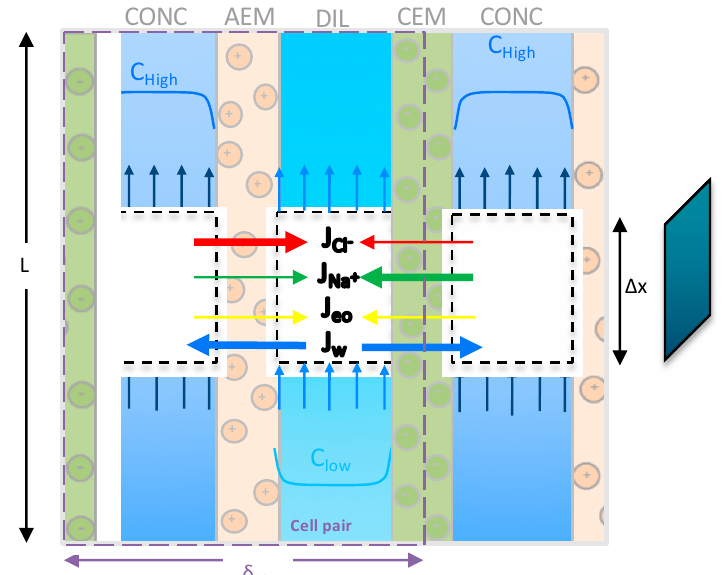
Figure 3. Schematic representation of the cell pair in the RED stack adapted from [45]. Figure 3 . Schematic representation of the cell pair in the RED stack adapted from [45].